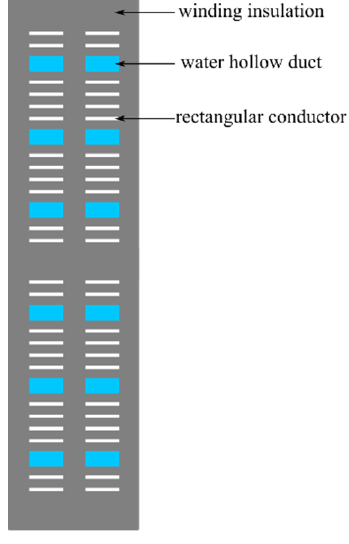
Figure 15. Water cold plate and classic water jacket solutions [98]: ( a ) water jacket; ( b ) water plates.